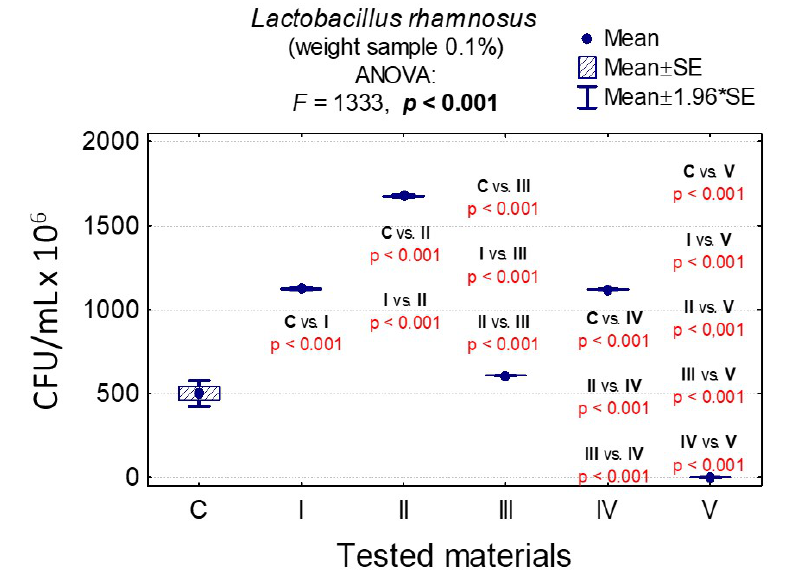
Figure 9. Average CFU / mL values and standard deviation (M ± SD) for Lactobacillus rhamnosus after temporary contact with the tested materials (C—growth control, I—nHAp, II—Cu 2 + -doped nHAp, III—nHAp with the addition of ozonated olive oil, IV—nHAp doped with Cu 2 + and loaded with ozonated olive oil, V—ozonated olive oil) for weights of 0.1% and results of analysis of variance (ANOVA) and multiple comparisons by a post-hoc test. Incubation took 24 h.